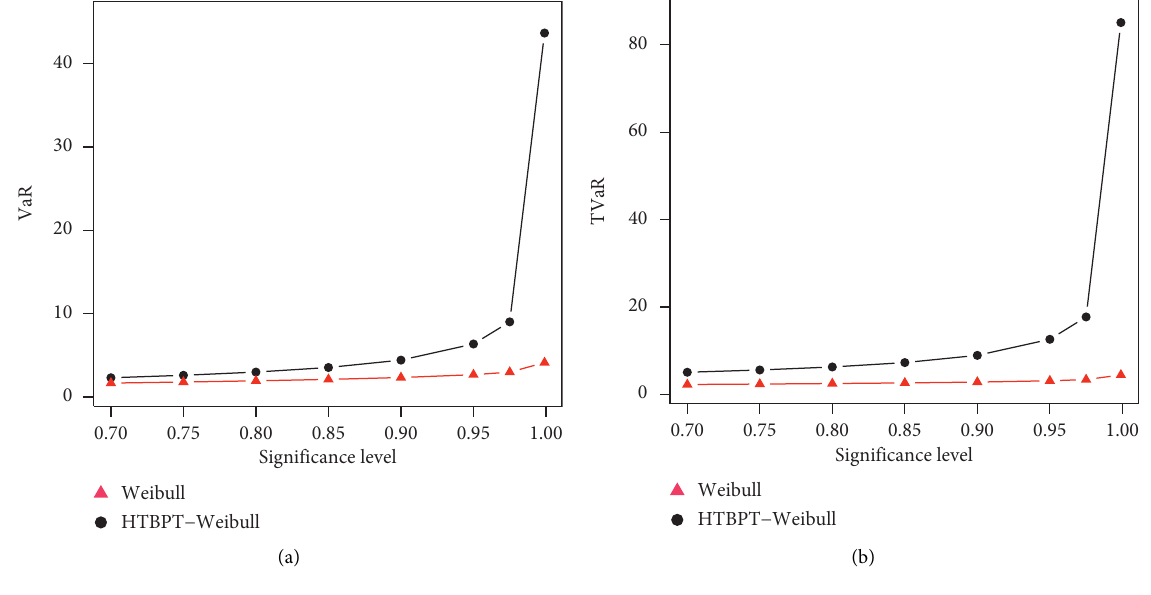
Figure 10: Graphical sketching of the numerical results provided in Table